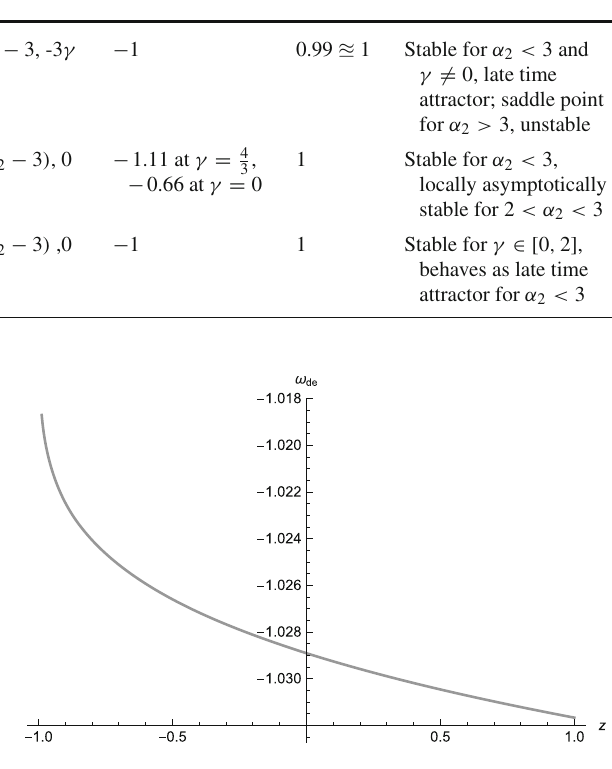
Fig. 6 The plot for ω de versus redshift z r for case I at E 1 m = 0 . 000097 ρ (cid:2) , γ = 4 , E 1 = 200, ξ = 1300 ρ 3